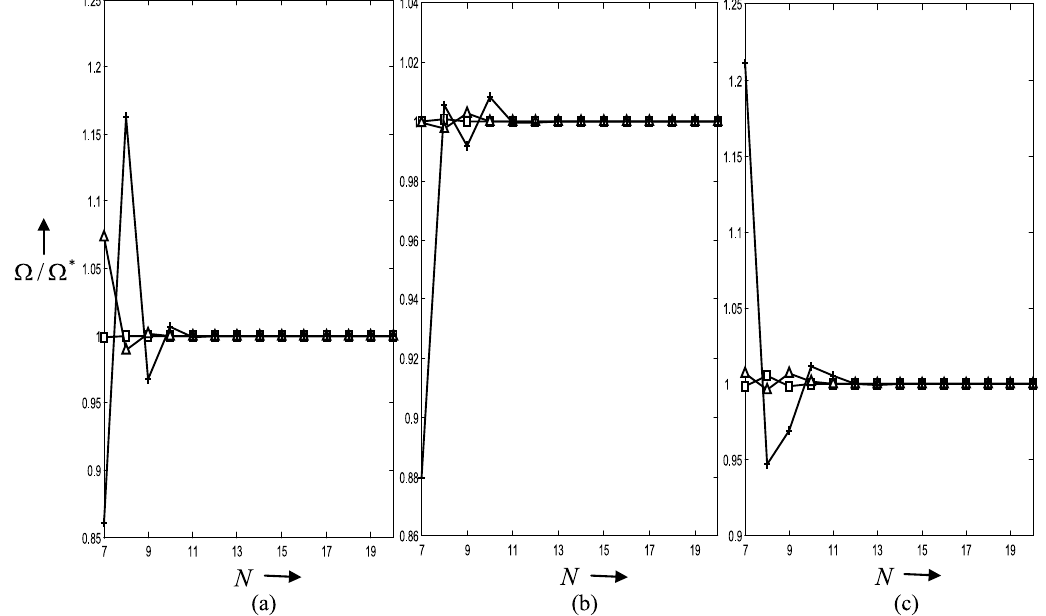
Fig. 3. Convergence of normalized frequency parameter Ω / Ω ∗ (a) C-C (b) C-S (c) C-F, with grid refinement for a/b = 1 ,N ∗ 0 = 20 ,γ = 1 . (cid:3) , first mode; (cid:4) , second mode; + , third mode. Ω ∗ – the DQ result using 20 grid